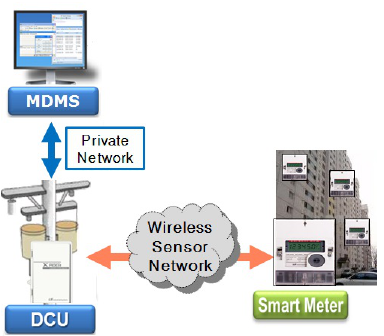
Figure 1. Architecture of the advanced metering infrastructure (AMI)